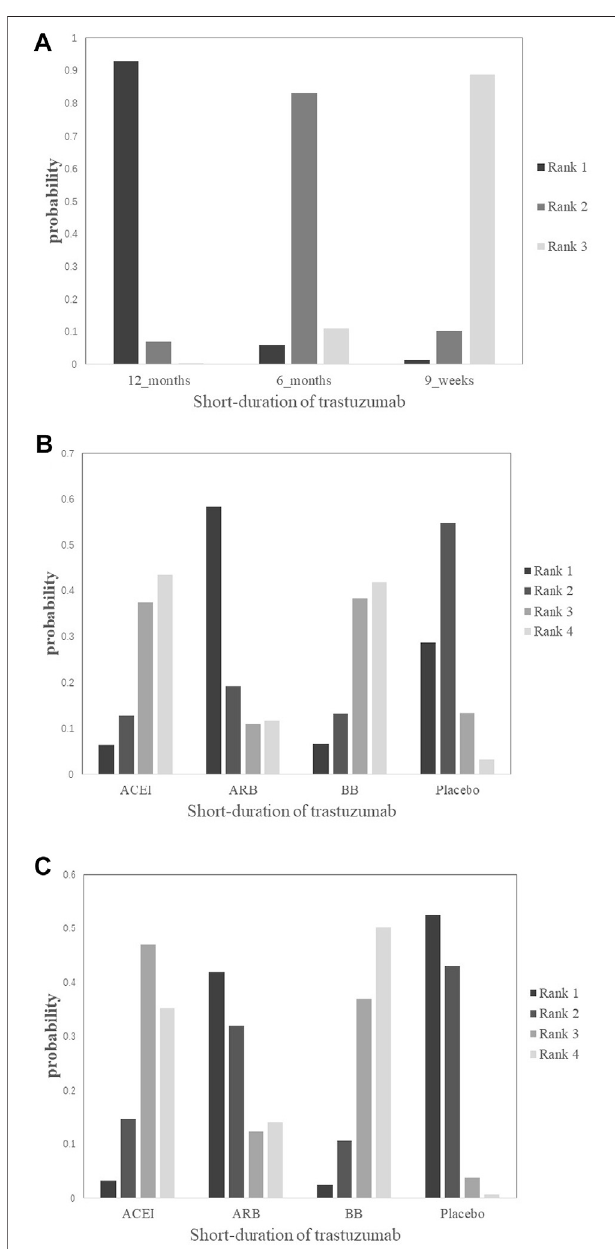
FIGURE 4 | Rank plots of the probability for cardiotoxicity in breast cancer patients receiving trastuzumab. (A) Short duration of trastuzumab using cardiotoxicity as the outcome; (B) cardioprotective drug intervention using cardiotoxicity as the outcome; (C) cardioprotective drug intervention using interruptions in trastuzumab therapy as the outcome.